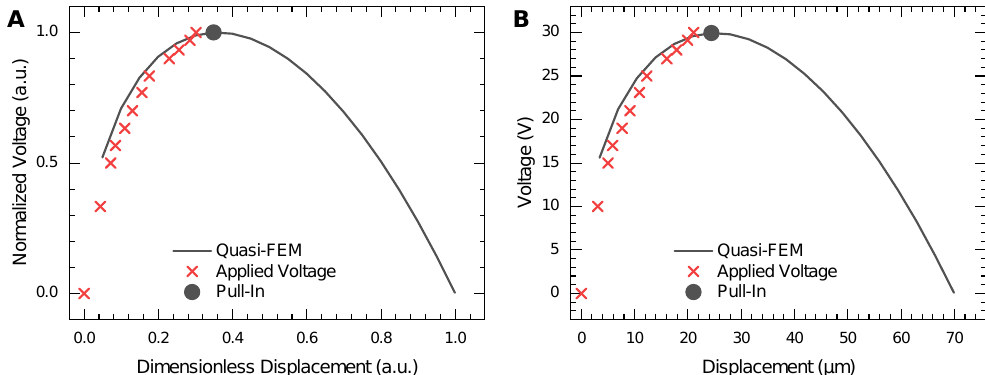
Figure 8. Results of modeling for PM with a 2800µm side length and a thickness of 25µm Al: ( A ) normalized voltage vs. dimensionless displacement; ( B ) voltage vs. displacements in absolute values.